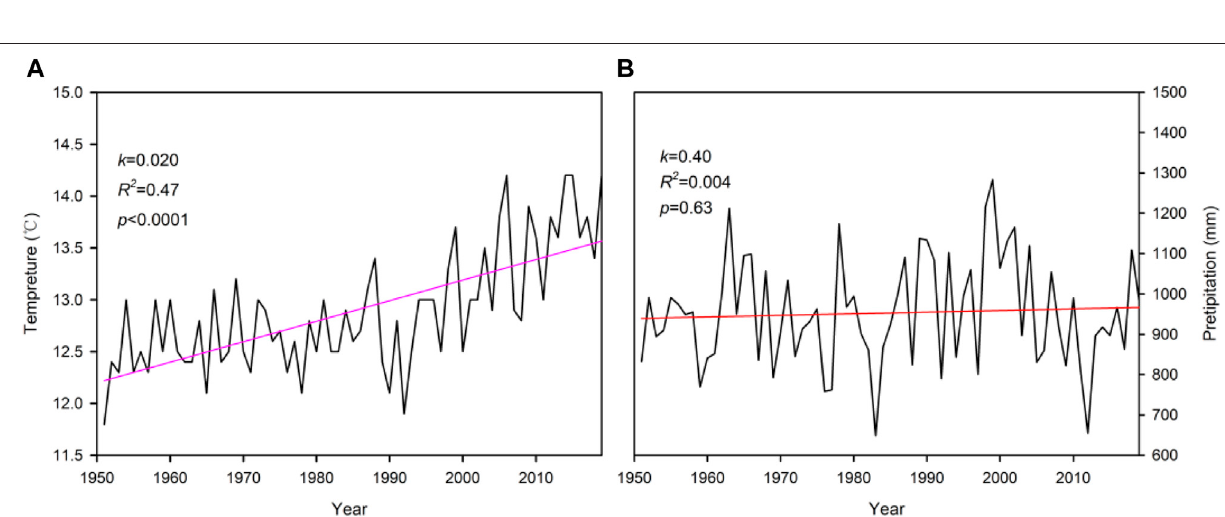
Frontiers in Earth Science |